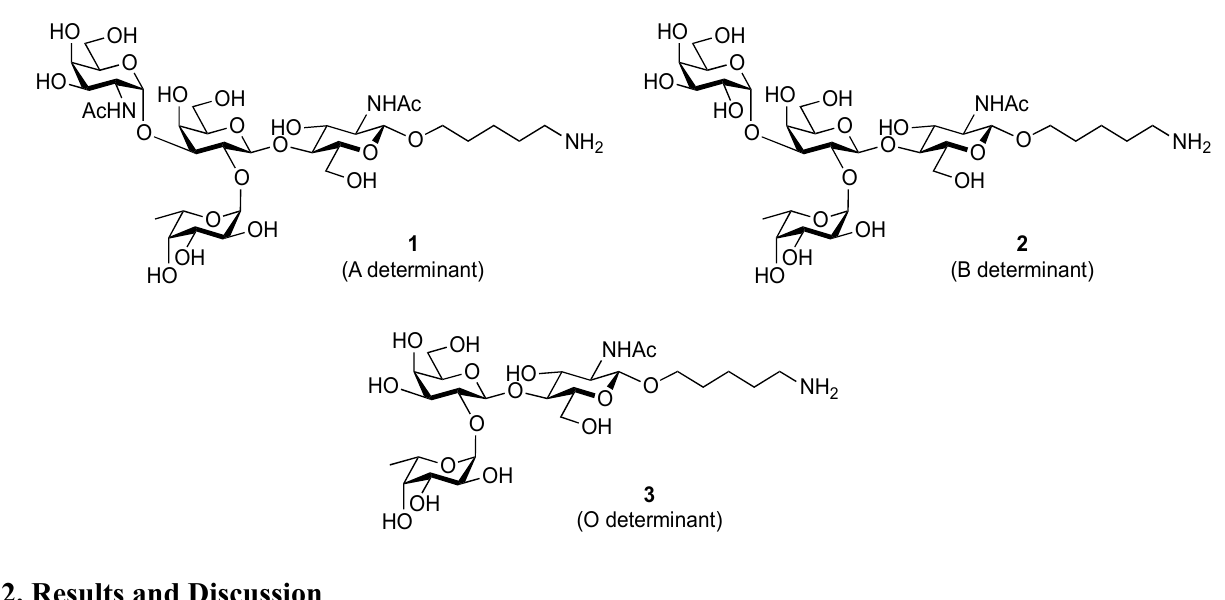
Figure 1. Structure of the target ABO blood-group type 2